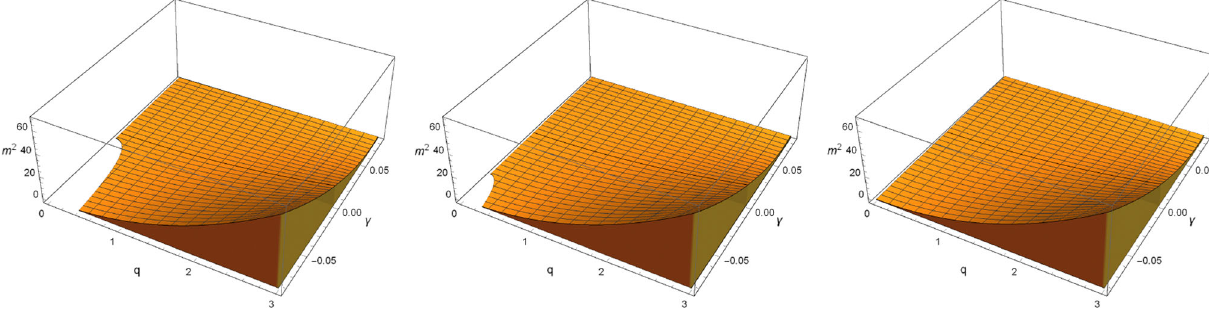
Fig. 6). But when γ = 1 / 12, such a forbidden